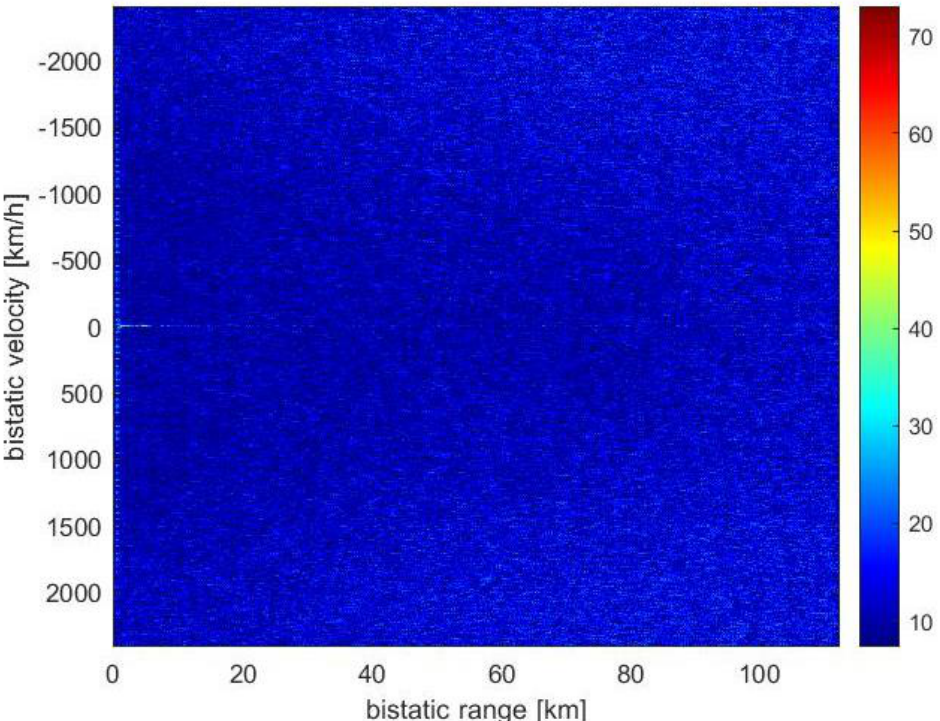
Figure 10. Range-velocity map without applying adaptive